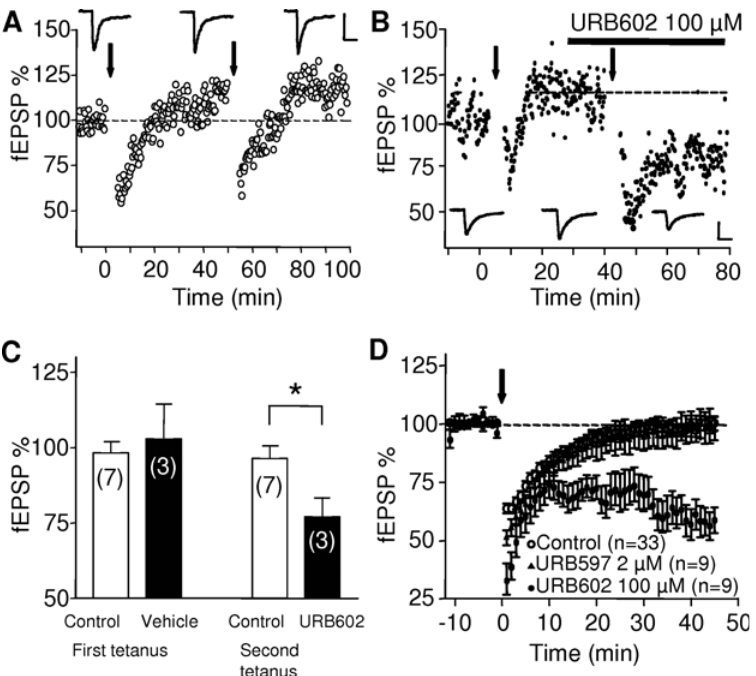
Figure 6. Role of 2-AG in eCB-LTD LTD in the PrPFC. (A) Typical experiment showing that a 5 min stimulation at 10 Hz is sub threshold to induce LTD, even when applied two consecutives times. Calibration bars: x: 10 ms, y: 0.2 mV. (B) Representative experiment showing that 5 min at 10 Hz can induce LTD when applied after bath perfusion with URB 602 (100 m M). Traces were taken at the time indicated on corresponding graph. Calibration bars: x: 10 ms, y: 0.2 mV. (C) Summary bar histogram of all the experiments performed where the first tetanus was given in saline and the second tetanus was given after bath perfusion of URB602. LTD was induced only when URB was present (t-test, p=0.0271). (D) Averaged time courses of the experiments in which the 5min at 10Hz protocol was given in control ACSF (open circles) of after pre-treatment with URB597 (2 m M, black triangles) or URB602 (black circles).